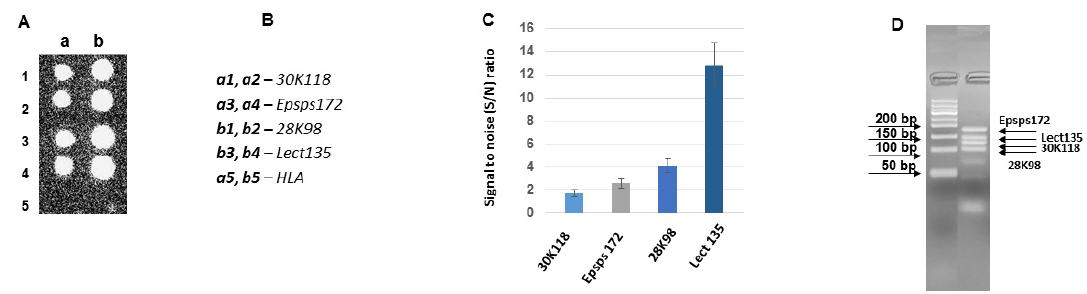
Figure 5. Hybridization of asymmetric multiplex PCR (N1) products with the probes Lect135, epsps172, 28K98 and 30K118 on a biochip. ( A ) Hybridization image ( a , b ) designations of the columns for the probe arrangement ; ( B ) The arrangement of the probes on the biochips; ( C ) Analysis of hybridization; the hybridization signal intensities estimated as signal to noise (S/N) ratio. ( D ) Agarose gel electrophoresis of asymmetric PCR products. Total DNA per hybridization is 1300 ng, the amount of fluorescent dye Cy3 is 18 pmol.